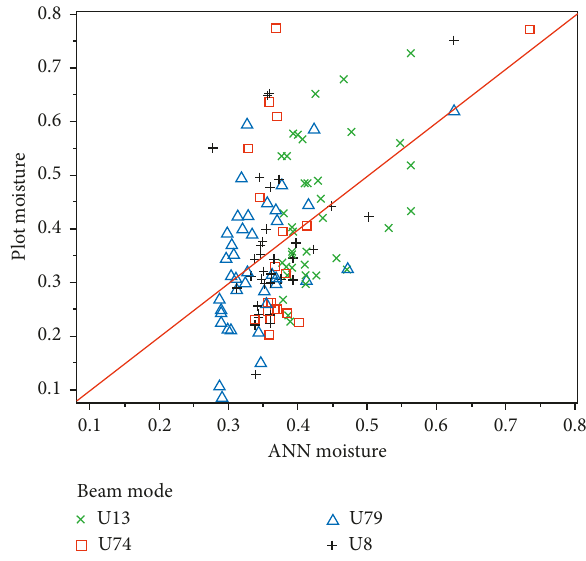
Figure 11: Combined ANN results versus plot-measured soil moisture. July 23 data are not included.